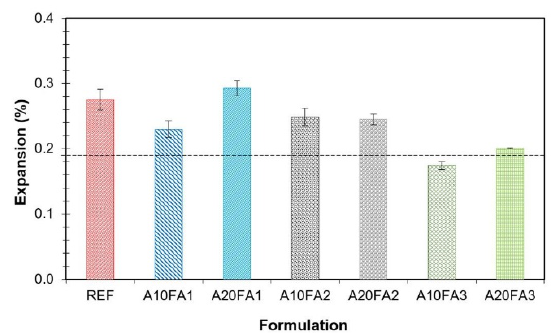
Figure 6. Expansion of mortars containing 10% and 20% of the origin A fines, after 28 days, in NaOH 1N solution